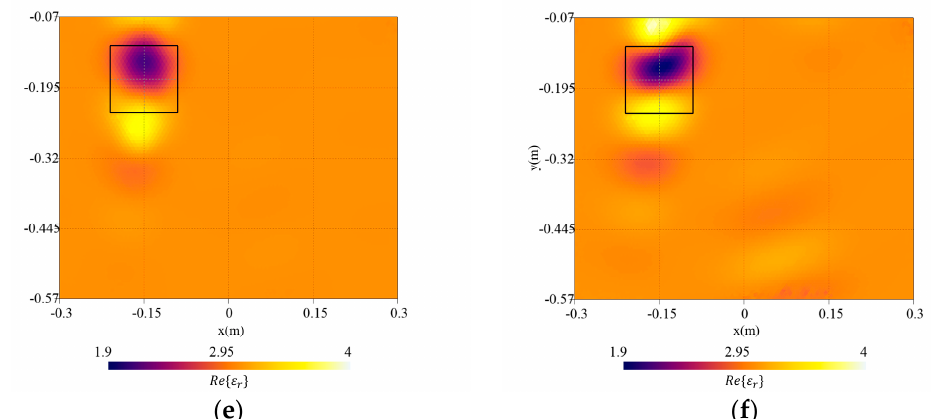
Figure 16. Reconstructed distribution of the real part of the complex dielectric permittivity, Re { ε r } , in the investigation domain together with a square box indicating the shape of the actual target. Cases of surface with h rms = λ and inversion with ( a ) exact interfaces and ( b ) planar interfaces; 30 h rms = λ and inversion with ( c ) exact interfaces and ( d ) planar interfaces; and h rms = λ 20 with ( e ) exact interfaces and ( f ) planar